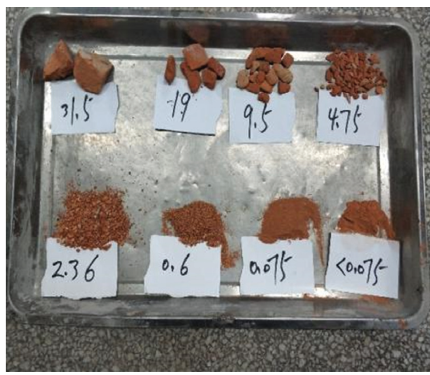
Figure 3: Sifted fractions of used clay bricks.